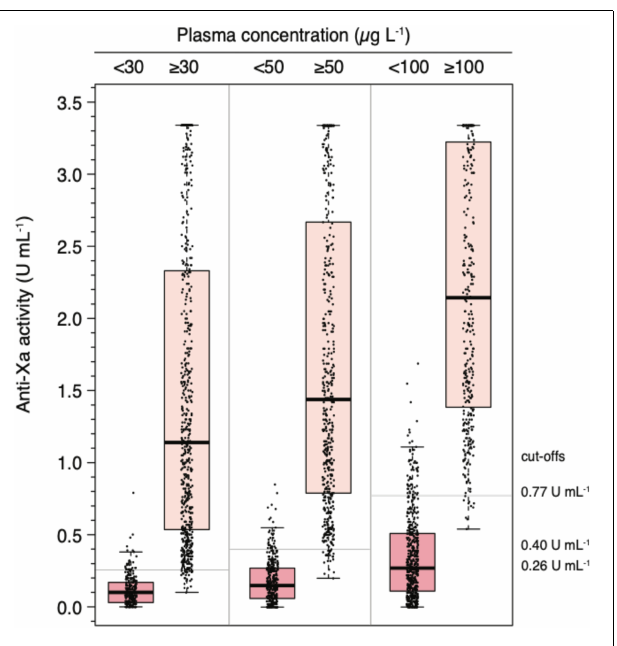
age was 76 years old (IQR, 66 to 82 years), and 42.9% of the patients were female, see Table 1